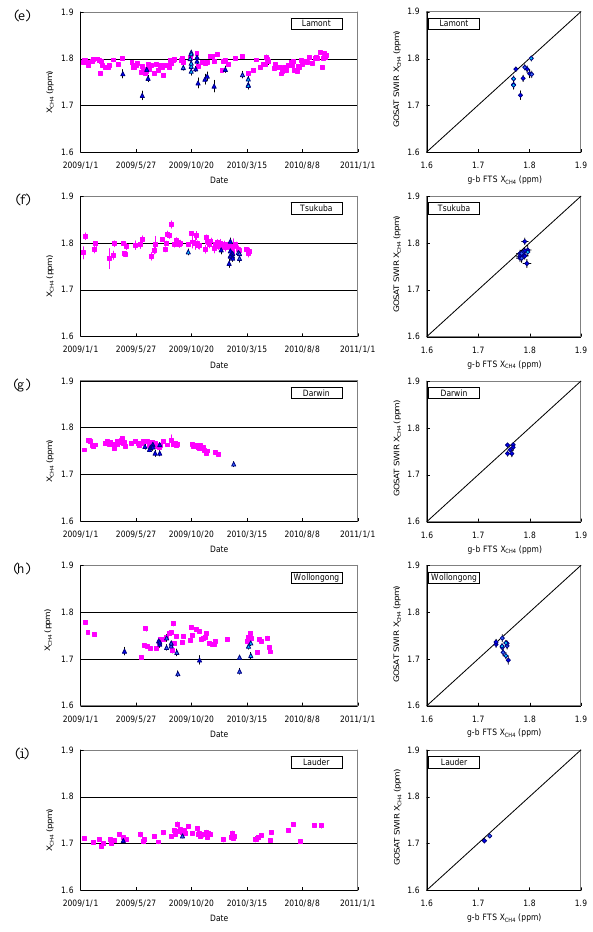
and X CH using a 2 4